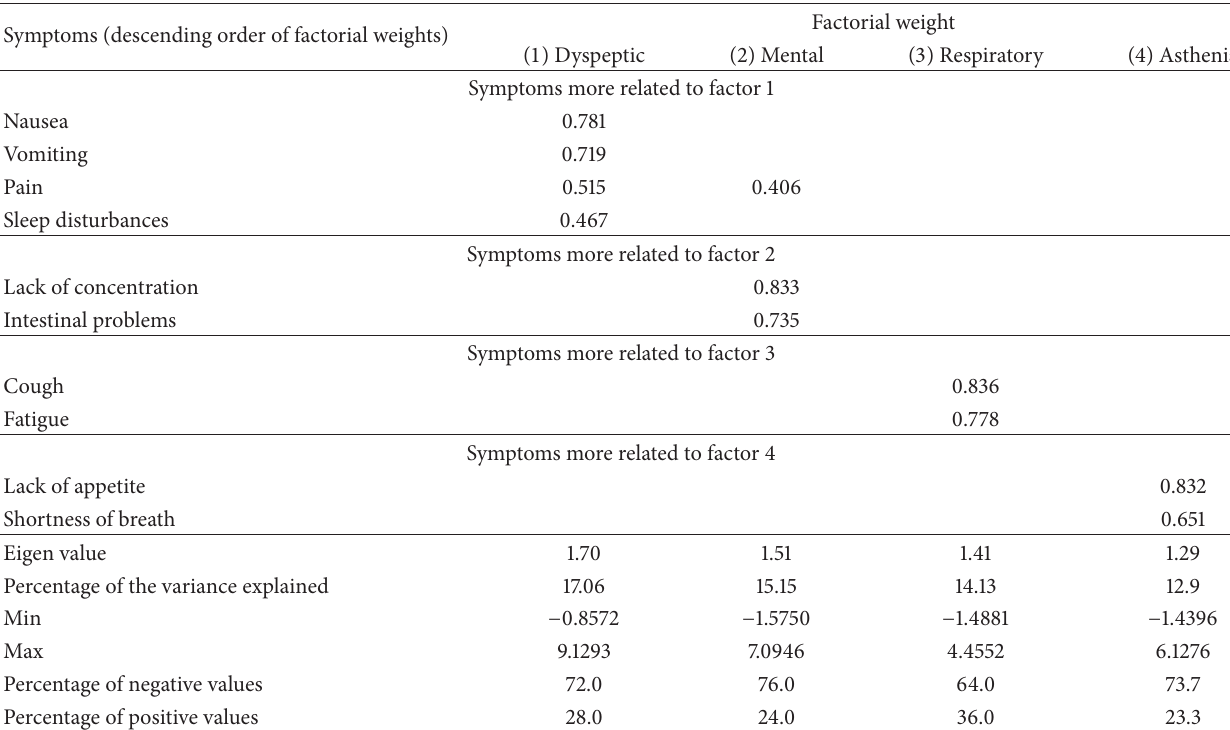
Table 5: Factorial distribution of seafarers’ distress symptoms after treatment.